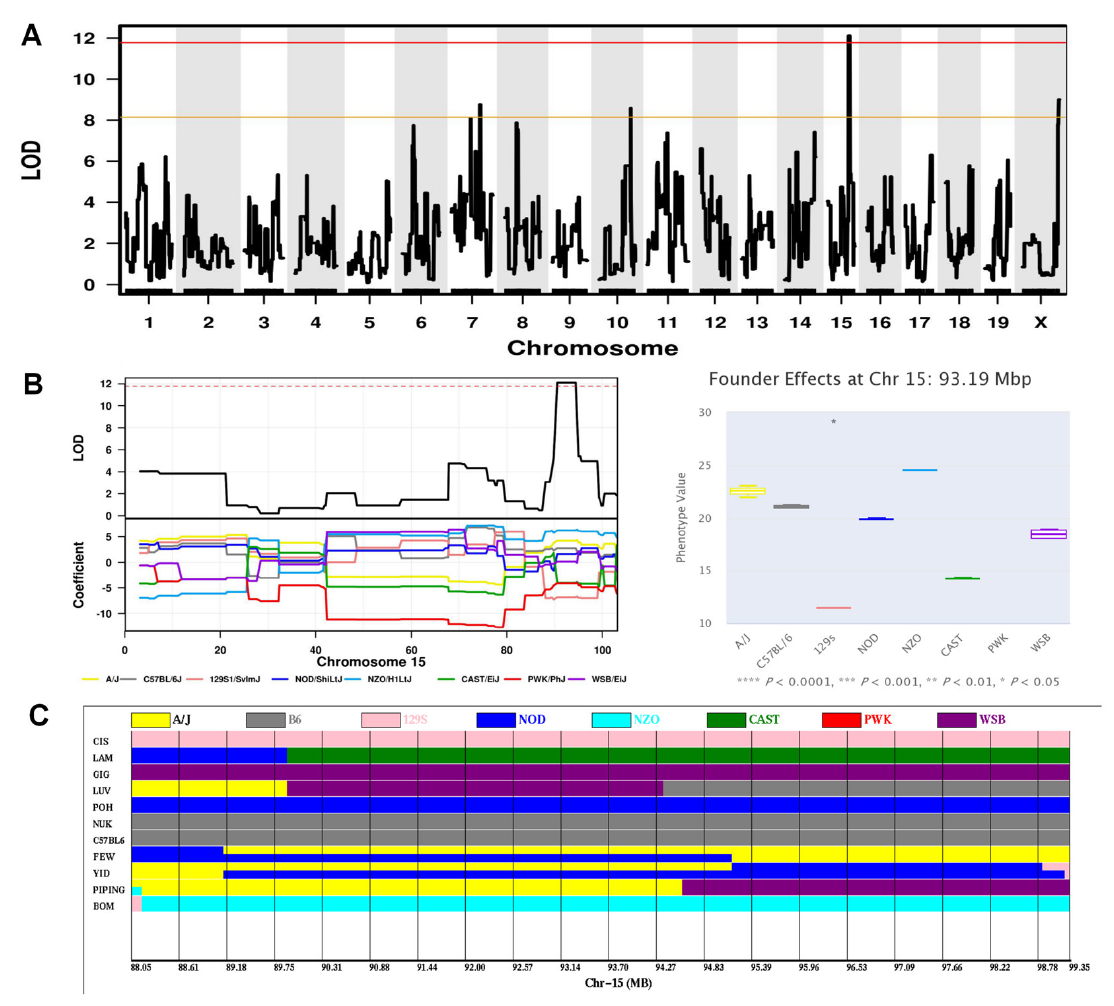
Figure 7. Mapping a significant QTL on Chr15 influencing the swim speed on the probe trial phase of MWM. ( A ) Genome-wide LOD scores. The x -axis shows the chromosomal position and the y -axis shows the LOD scores. The solid red and orange horizontal lines indicate thresholds of 95% and 63% genome-wide significance, respectively. ( B ) LOD scores (upper left panel) on Chr15, and founder coefficient plot (bottom left panel) for Chr15. The dashed red horizontal line indicates thresholds of 95% significance. The association of founder haplotypes at 93.19 Mbp with this trait analyzed is shown in the right plot, indicating that the haplotypes of CAST and 129S1 ( p < 0.05) were associated with lowest swim speed. ( C ) Founder haplotypes in all CC strains at position 88.05–99.35 Mbp on Chr15. Strains are listed in the order from slower swim speed (top) to faster swim speed